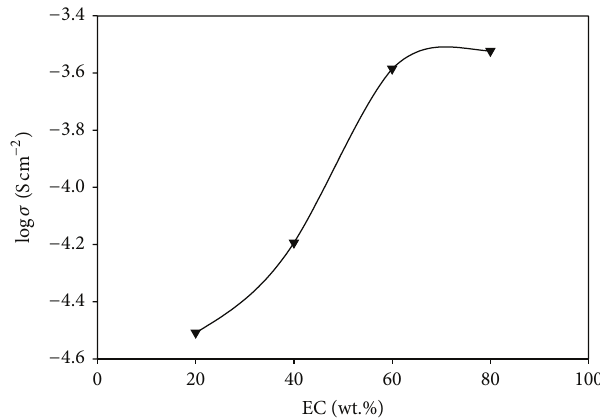
Figure 3: Variation of ionic conductivity of P(GMA-co-MMA)-EC- LiClO 4 based polymer electrolyte as a function of EC